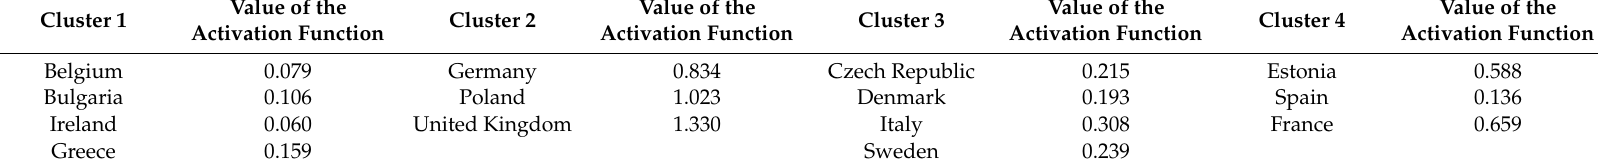
Table 7. Division of the EU countries into homogenous groups by the total value of emissions of harmful substances together with the values of the activation function (own elaboration). Cluster